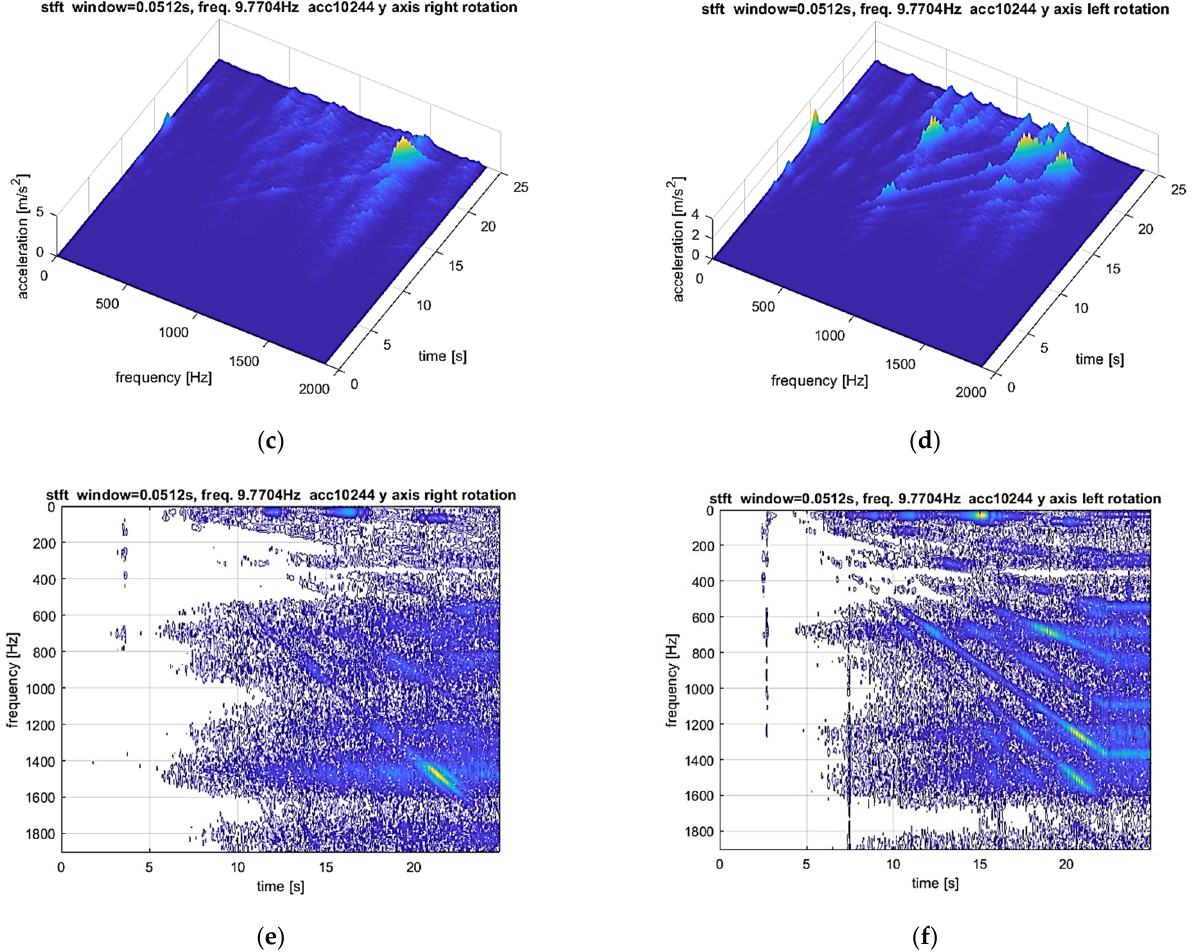
Figure 10. ( a ) Vibration waveform: flexible coupling, direction (axis) y; ( b ) vibration waveform: locked coupling, direction (axis) y; ( c ) 3-D STFT: flexible coupling, direction (axis) y; ( d ) 3-D STFT: locked coupling, direction (axis) y; ( e ) map of STFT: flexible coupling, direction (axis) y; and ( f ) map of STFT: locked coupling, direction (axis) y.